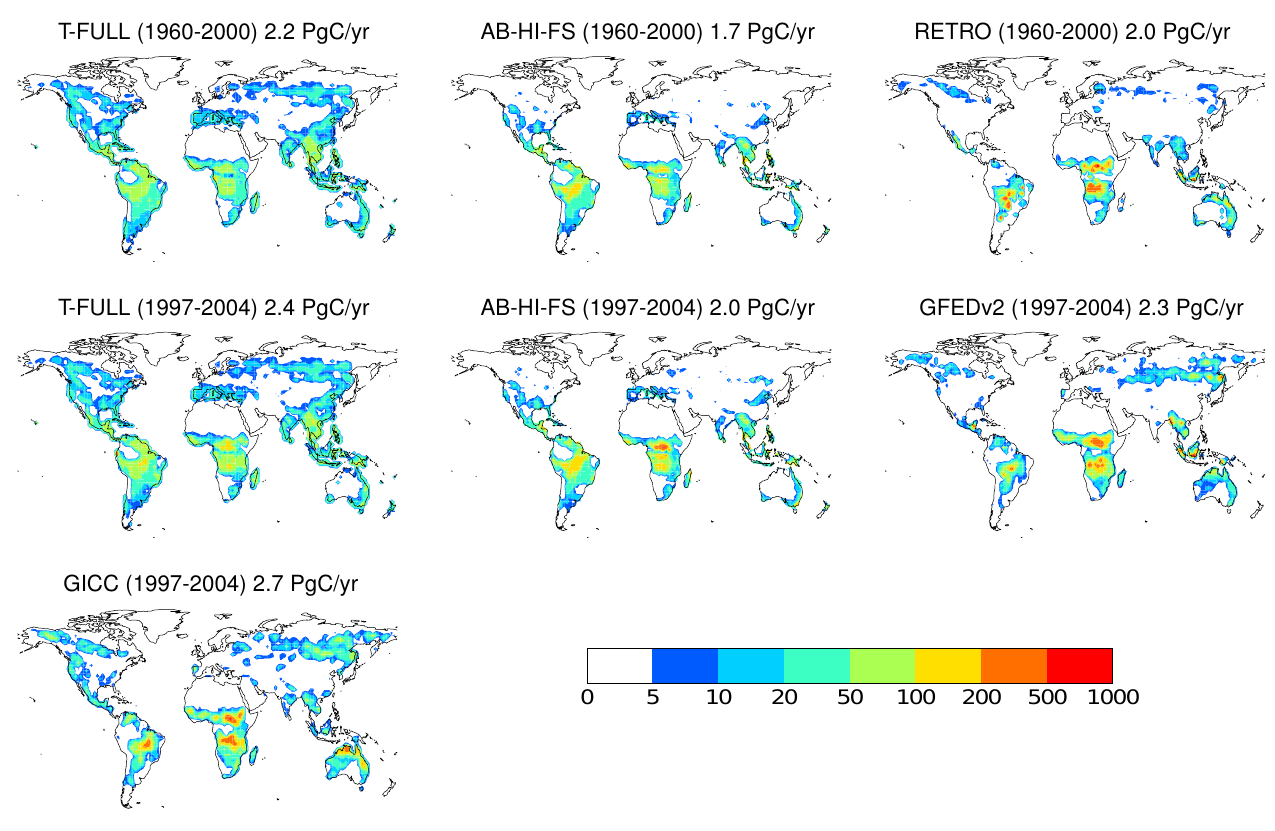
Fig. 3. Annual mean total (wildfire plus deforestation) fire carbon emissions [gC/m 2 / year] compared to emissions reported in the fire products GFEDv2 (van der Werf et al., 2006), RETRO (Schultz et al., 2008) and GICC (Mieville et al., 2010). The model simulations are averaged over the corresponding observational periods (GFEDv2/GICC: 1997–2004; RETRO: 1960–2000). The numbers in the title of each panel are global mean fire emissions with units of PgC/year. Regional values for all simulations performed are given in Fig. 4. 25% higher than reported in L3JRC. A study from Ito et